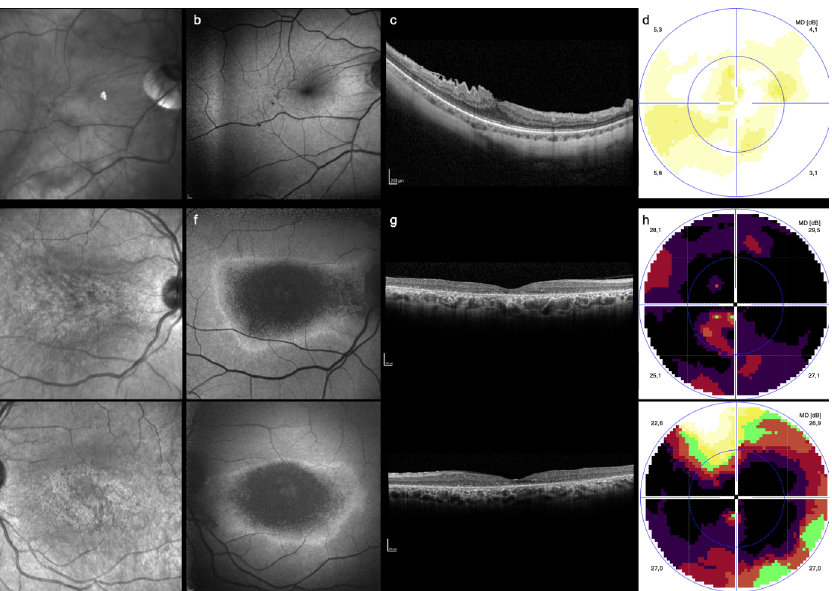
Figure 1. Exams of the two patients advised to stop HCQ usage. The first case related to a 60-year-old female using HCQ for 84 months (about 7 years). A right-eye epiretinal membrane was noted in the ( a ) NIR image, ( b ) FAF and ( c ) SD-OCT. The ( d ) 10-2 visual field showed a mild decrease of retinal sensitivity, and suspension of the drug was recommended. The second case ( e – h ) corresponds to a 59-year-old female using HCQ for 320 months (around 27 years) but with inconsistent screening, who was found to have bull’s eye maculopathy (right eye, top; left eye, bottom). Note the changes in both the ( e ) NIR image and ( b ) FAF and the advanced outer retinal atrophy in ( c ) SD-OCT. The ( h ) 10-2 visual field showed a bilateral central